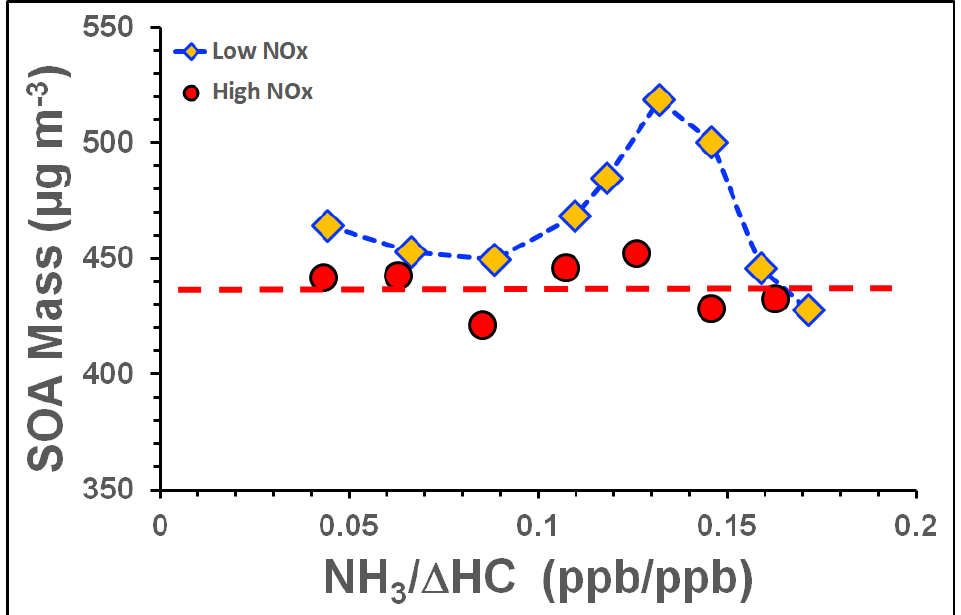
Figure 8. SOA mass as a function of the ([NH 3 ]/[  HC]) ratio at 80% RH under low and high NOx scenarios. Blue and red dotted lines are the eye guiding lines for low and high NOx scenarios, re- spectively. narios. Blue and red dotted lines are the eye guiding lines for low and high NO x scenarios,